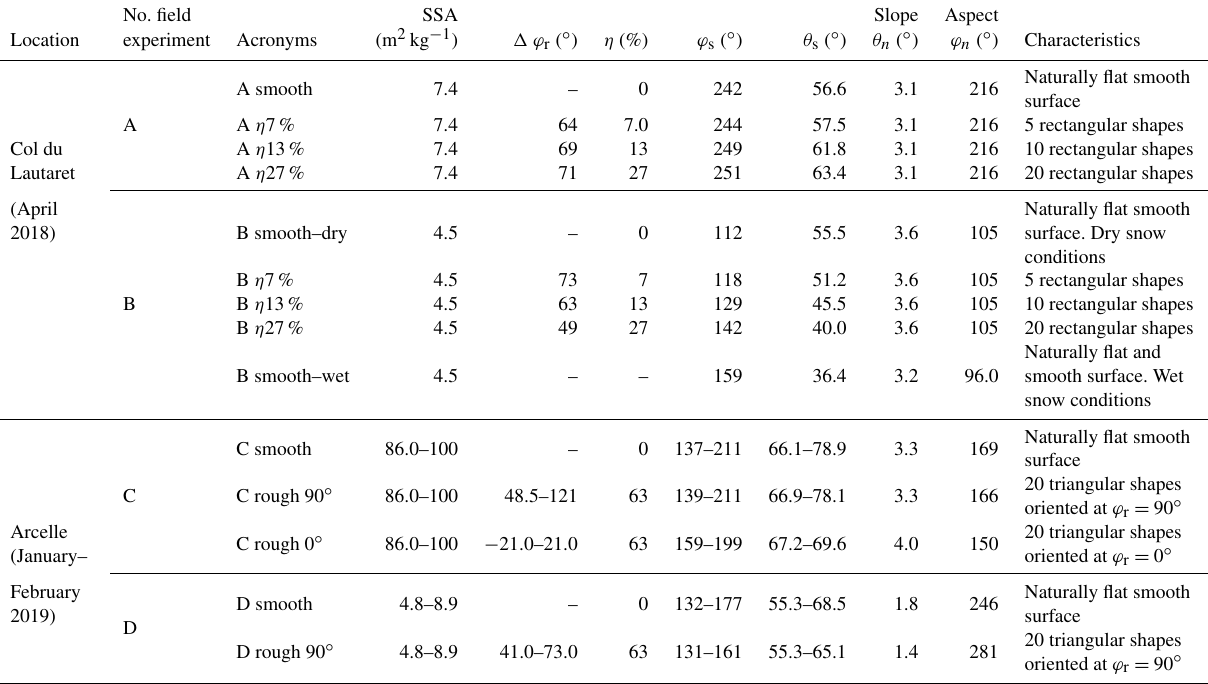
Table 1. Details of field experiments. The sensor’s height is fixed at 65cm. No.